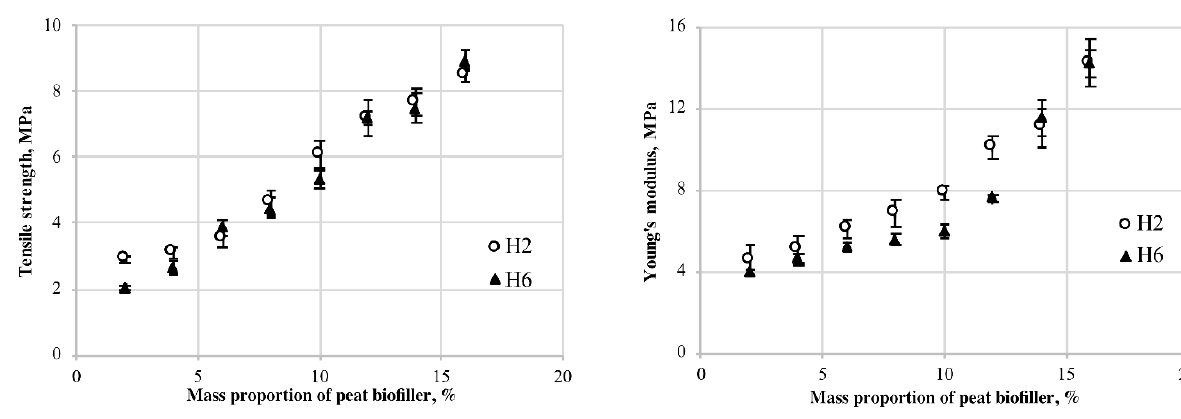
Figure 8. Tensile stiffness (Young’s modulus) as a function of the mass proportion of biomass in